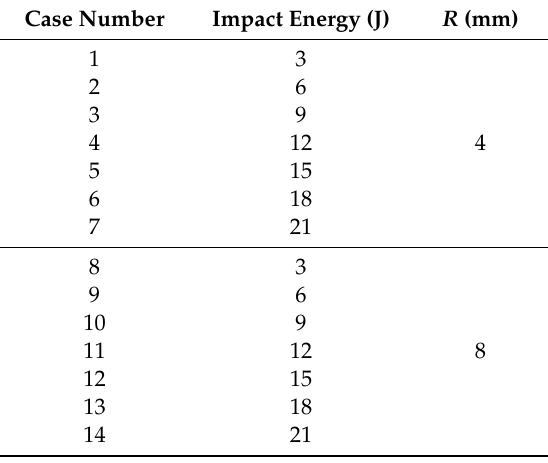
Figure 2. The images of radius of curvature in the nose part of the impactor (R): ( a ) a schematic explanation of R of impactor; ( b – f ) impactor nose shapes with different R: ( b ) 4 mm, ( c ) 8 mm, ( d ) 16 mm, ( e ) 32 mm, and ( f ) 64 mm. Table 2. Impact test cases according to the impact energy and R.